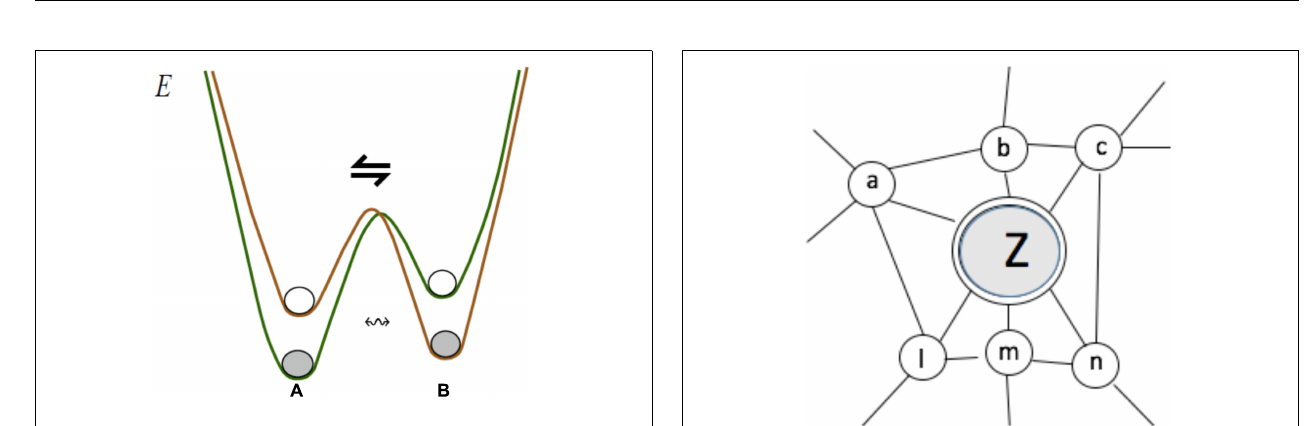
FIGURE 7 | Associative structures reside in continuous energy landscape. Coordinating objects A and B occupying different minima (A B) → (A (cid:11) B) requires repetitive climbing over the energy “hill” between the minima. Deformation in the landscape (lowering the “hill”) enables blending (A (cid:11) B) → (A (cid:33) B), producing a structure where A and B remain distinct and, at the same time, capable of constraining each other’s behavior.